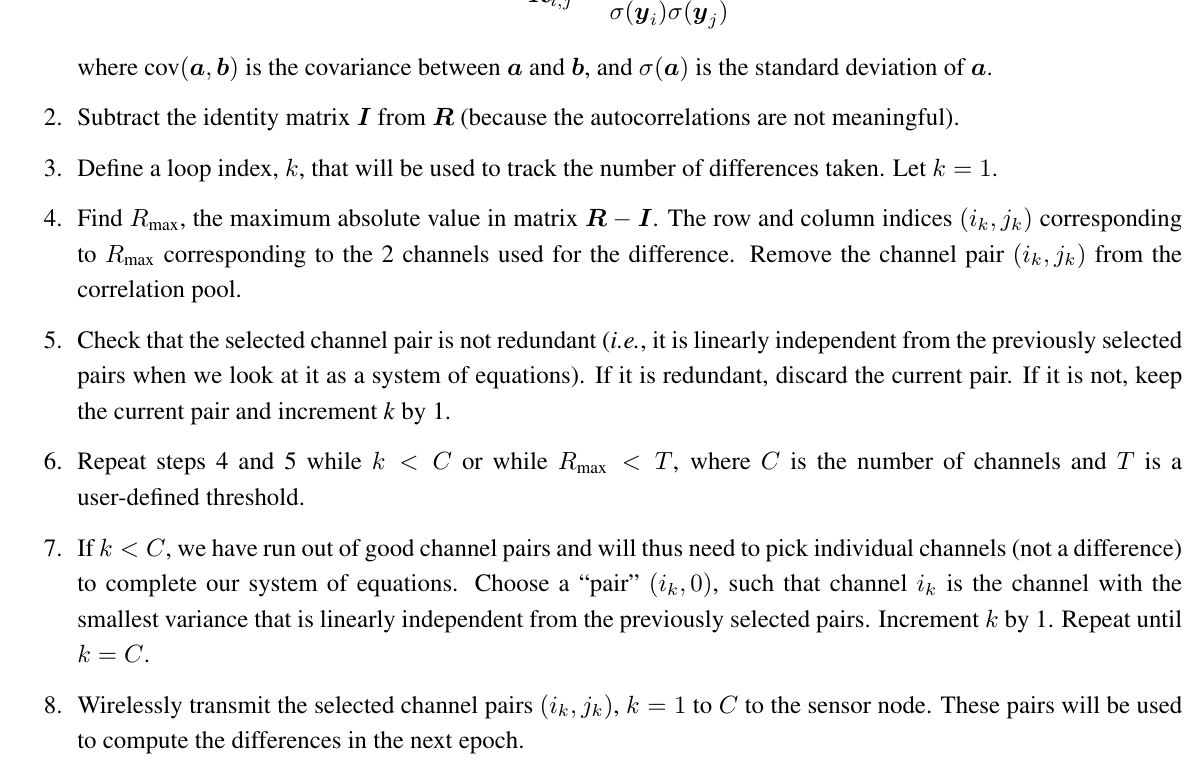
Algorithm 1. The interchannel redundancy removal